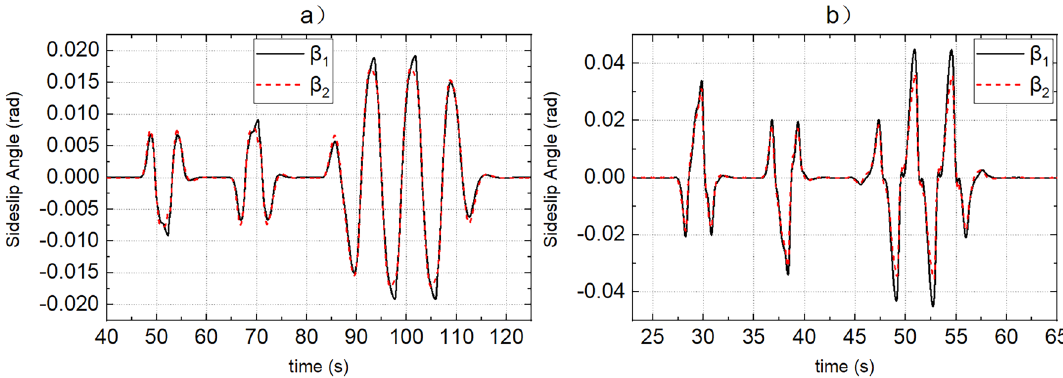
Figure 10. ( a , b ) Show the actual sideslip angle when the road adhesion coefficients are 0.15 and 0.8, respectively. Curve 1 represents the SCS effect, and curve 2 represents the MMCCS effect.